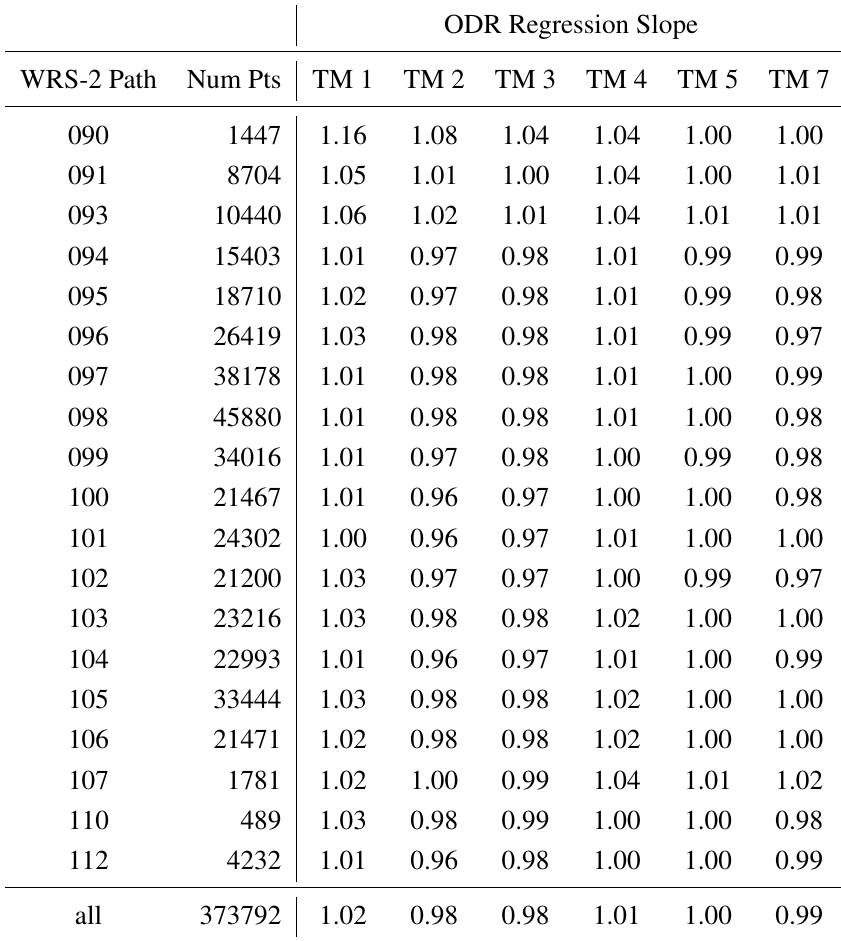
Table 4. ODR regression slopes between ETM+ and OLI surface reflectance, for all available scenes in each WRS-2 path. Band columns are labelled with their TM